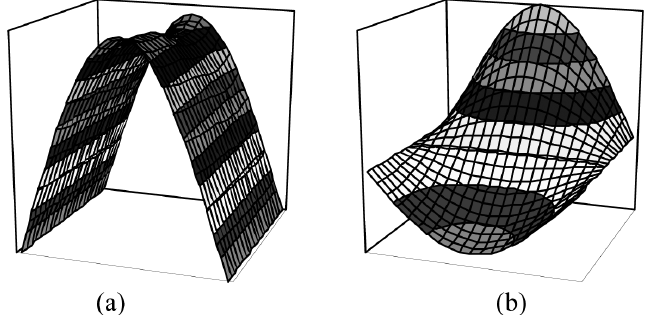
Fig. 6. The fi rst two coupled modes of a SFSF square plate with two sprung masses ( ξ 1 = 0 . 4 , η 1 = 0 . 4 , ξ 2 = 0 . 6 , η 2 = 0 . 4) . (a) the mode corresponding to Ω 1 = 8 . 2505 , (b) the mode corresponding to Ω 2 = 16 . 736